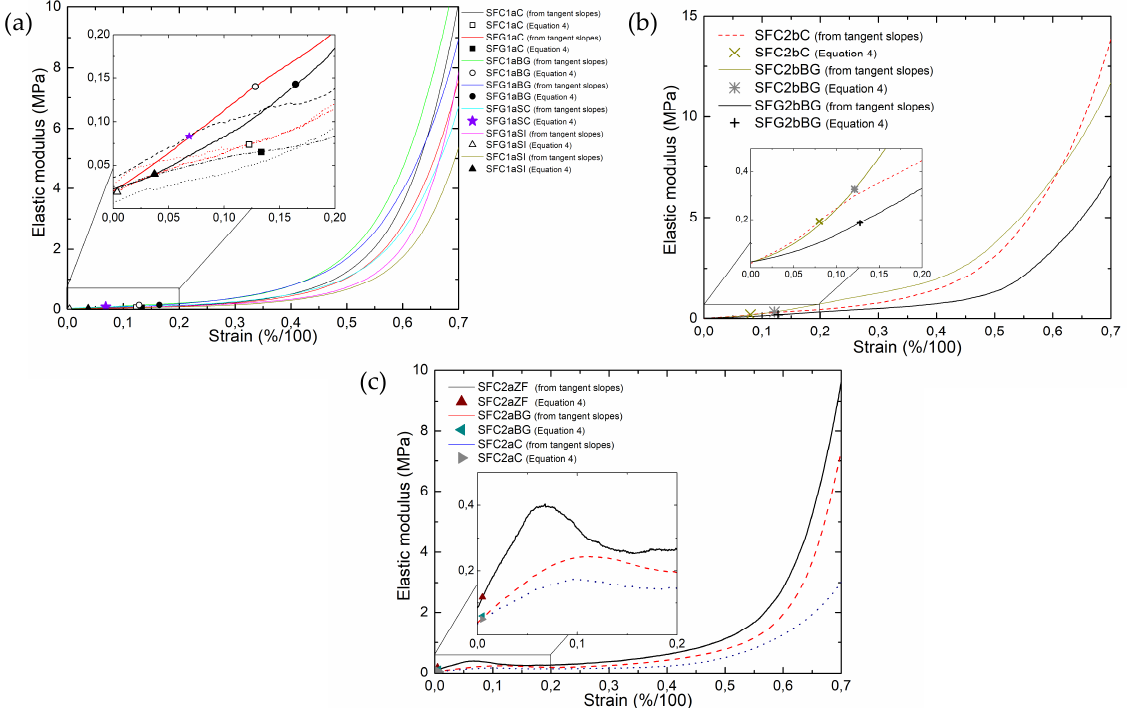
Figure 6. Elastic modulus ( E *) calculated by Equation (6) (symbols) and slopes of the tangents to the experimental stress-strain curves (lines) for soft CFs derived from: ( a ) Rayon; ( b ) PAN (thick fibers) and ( c ) PAN (thin fibers).